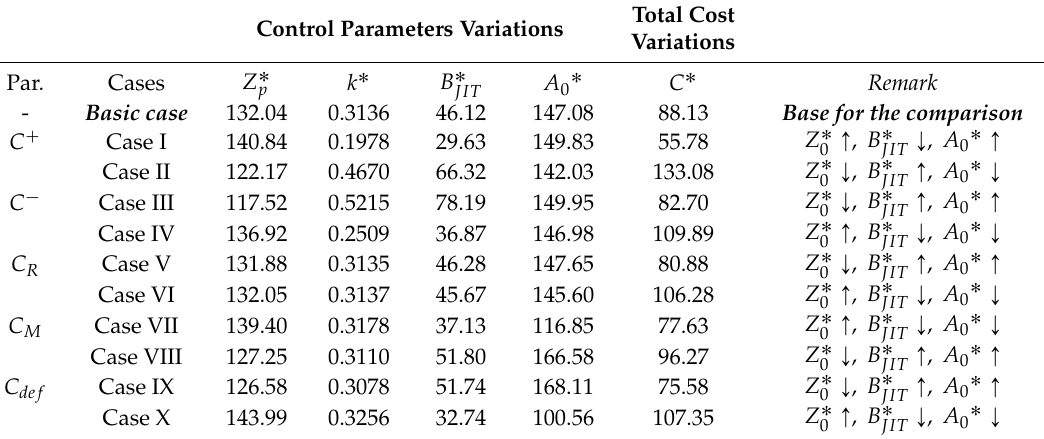
Table 7. Sensitivity analysis for different cost